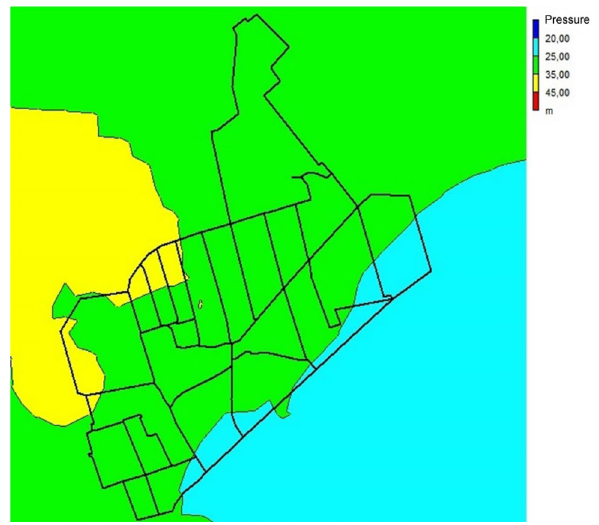
Fig. 9 The pressure distribution in the model of the water distribution system at the hour of the highest water consumption